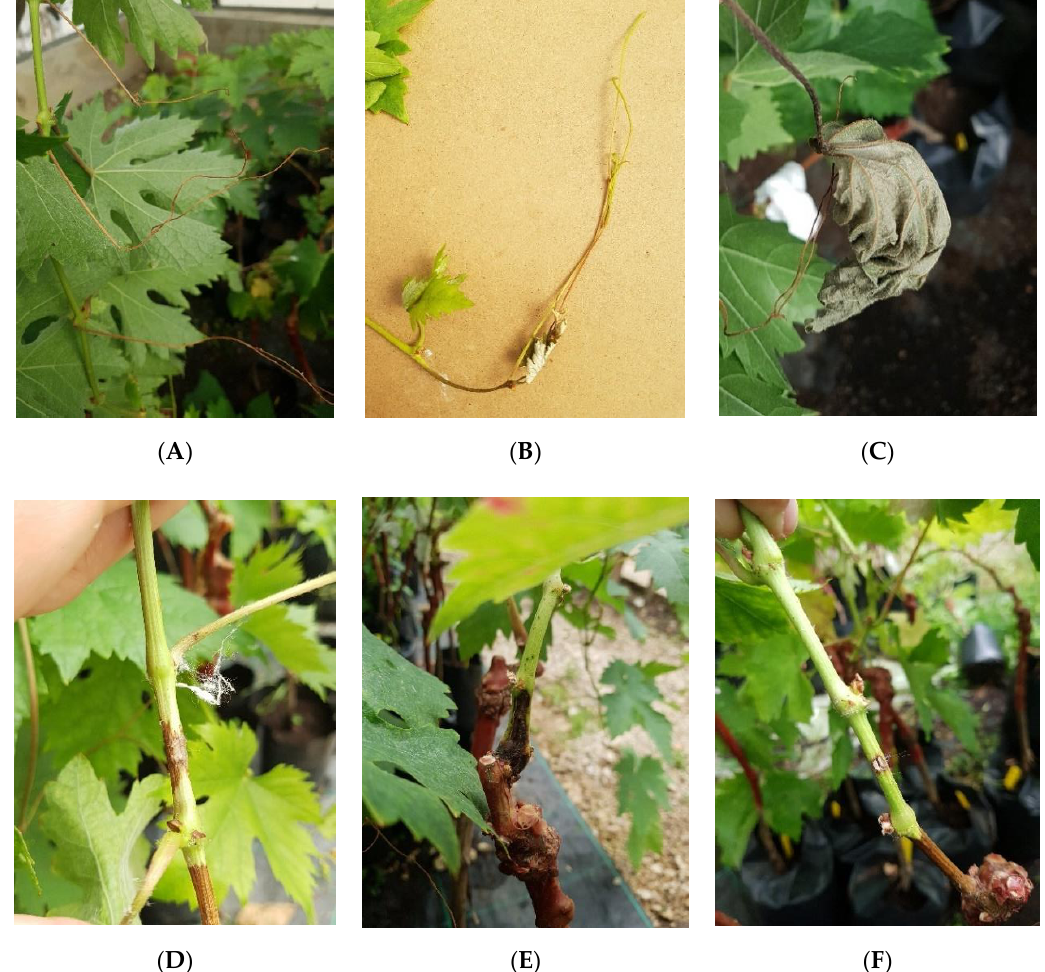
Figure 1. Symptoms observed on tendril and green shoots: ( A ) necrotic tendrils obtained after inoculation with D. mutila (Bt218); ( B ) necrotic apex of the shoot after inoculation with D. seriata (Bt204); ( C ) necrotic leaf after inoculation with N. parvum (Bt216); ( D ) lesion obtained after inoculation with D. seriata (Bt204); ( E ) lesion obtained after inoculation with N. parvum (Bt216); ( F ) control inoculation.